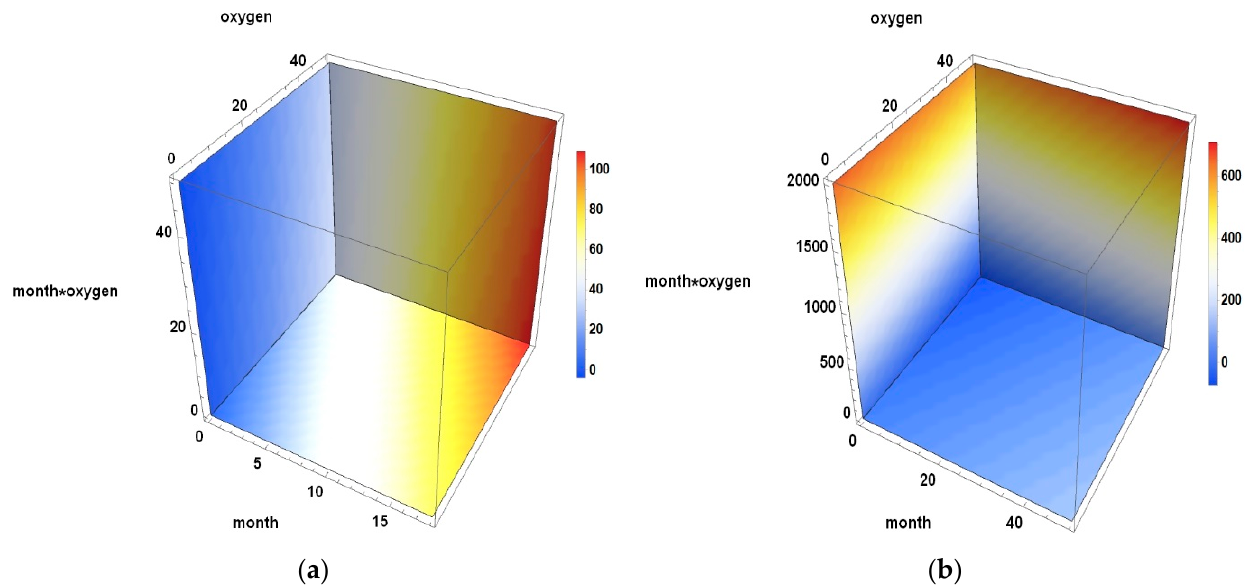
Figure 8. Predicted values of the corrosion depth obtained on the basis of regression models formed for the behaviour of the alloy under the influence of tide on NiTi1 ( a ) and NiTi2 alloy ( b ).